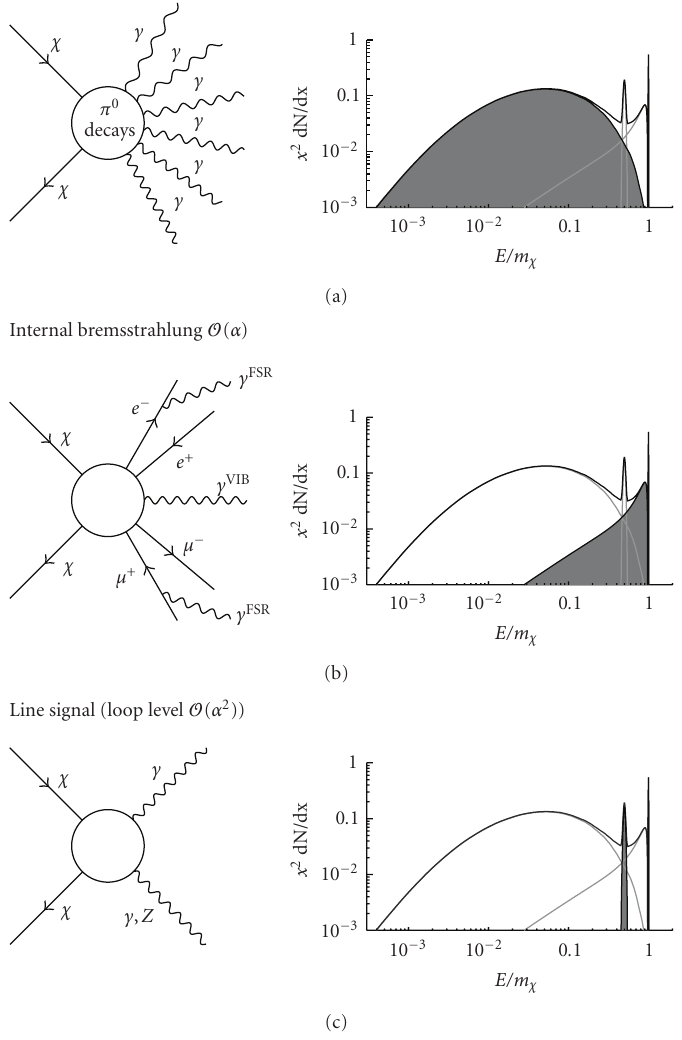
Figure 1: A schematic of the di ff erent sources and energy distributions of γ -rays from WIMP annihilation. (a) Secondary photons arising from the decay of neutral pions produced in the hadronization of primary annihilation products. (b) Internal bremsstrahlung photons associated with charged annihilation products, either in the form of final state radiation (FSR) from external legs or as virtual internal bremsstrahlung (VIB) from the exchange of virtual charged particles. (c) Monochromatic line signals from the prompt annihilation into two photons or a photon and Z boson. This process occurs only at loop level, and hence is typically strongly